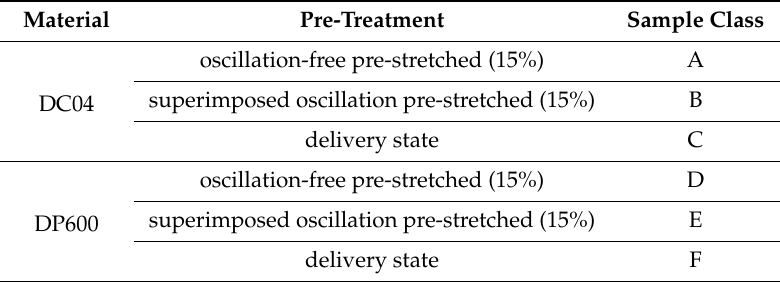
Table 2. Sample classes for fatigue